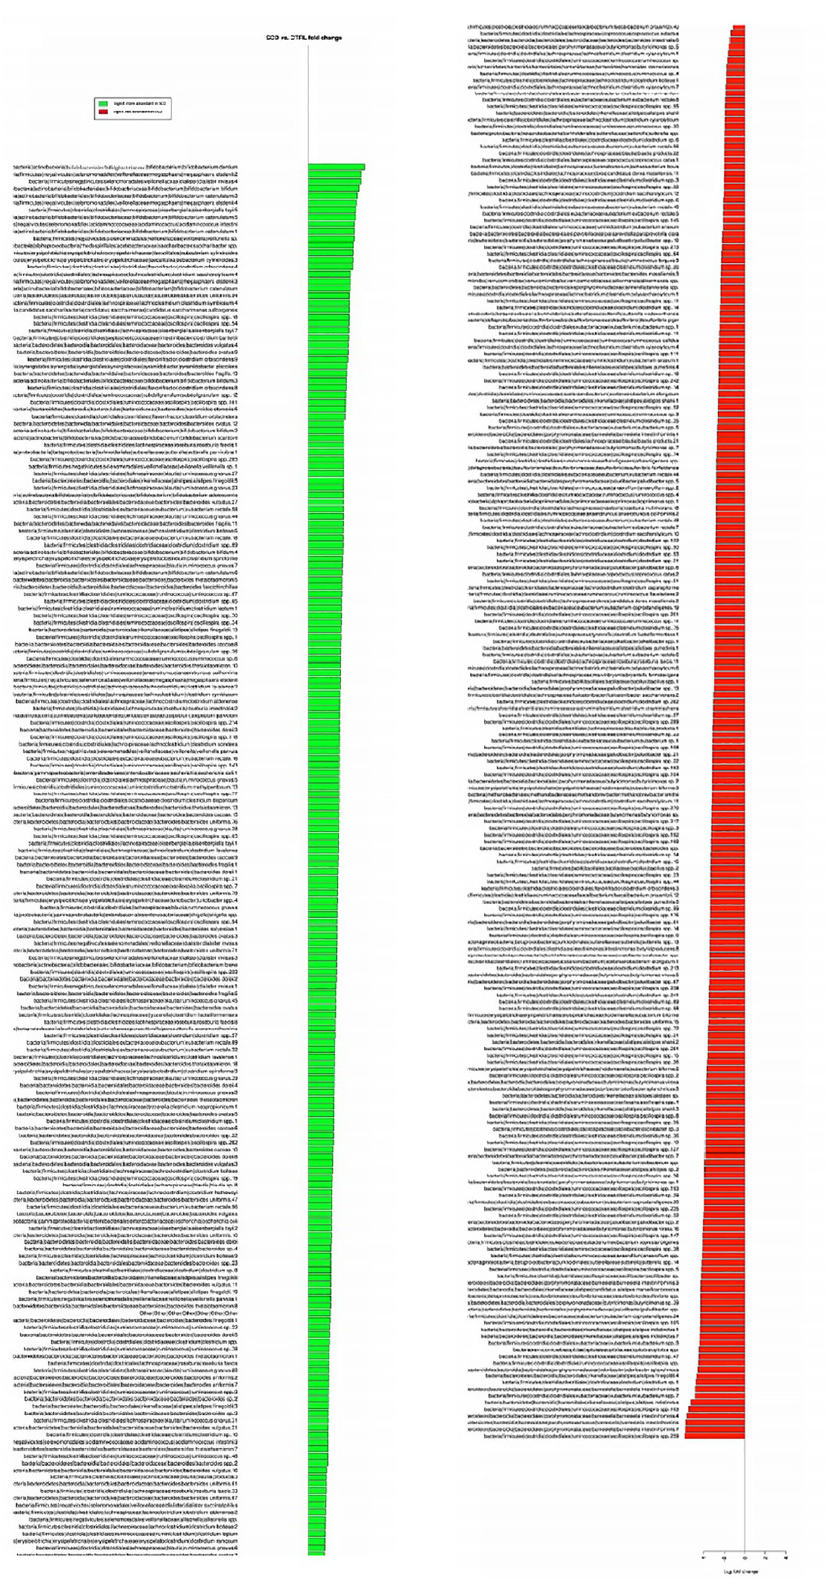
Fig 2. Differential OTUs between SCD subjects and healthy controls’ stool samples.